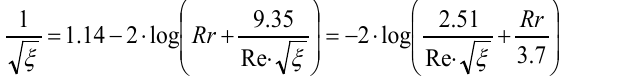
Figure 1 Prandtl’s universal law of friction (8) and Nikuradse’s